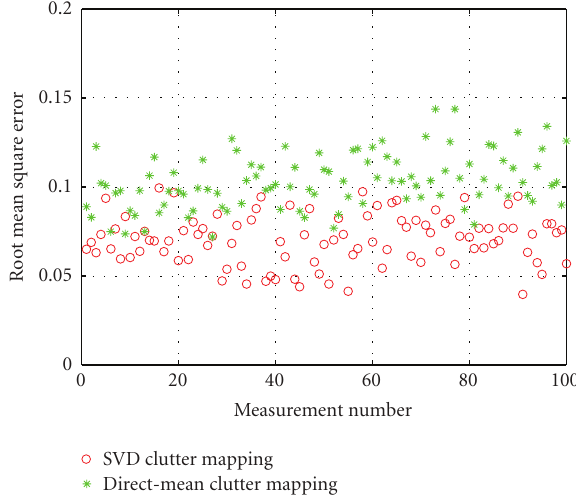
Figure 11: RMSE values for evaluation of the SVD and the direct- mean clutter mappings with a moving